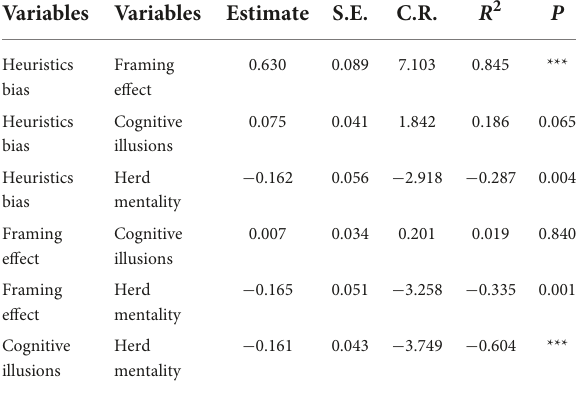
TABLE 6 Estimates of independent